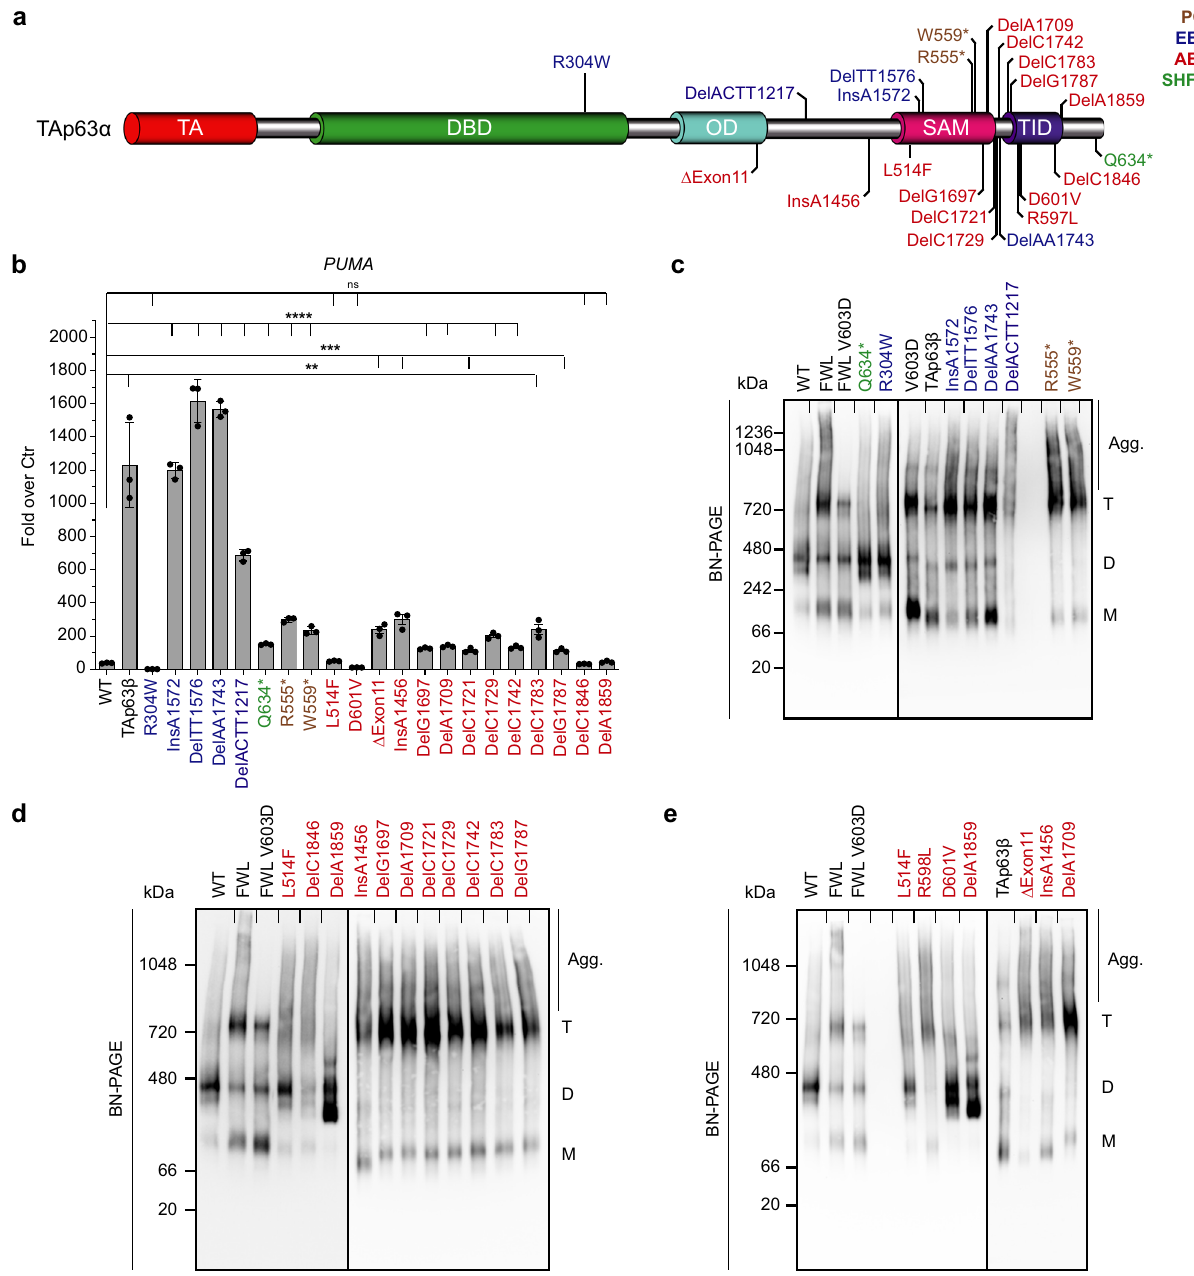
Fig. 5 Analysis of TAp63 α mutants ’ transactivation activity and oligomeric states. a Overview of different syndromic mutations on TAp63 α . ELA mutations are represented in blue, AEC/RHS in red, SHFM in green and POI mutations in brown. b The relative luciferase activity expressed as fold over control (Ctr) shows the ability of wild-type or mutant p63 variants to transactivate the PUMA promoters. n = 3 biologically independent experiments, luciferase assay was performed in triplicates on PUMA 4xBS2WT responsive elements (REs). Data are presented as mean ± SD, ** p -value < 0.01, *** p -value < 0.001, **** p -value < 0.0001, ns p -value > 0.05 by two-tailed unpaired Student ’ s t -test. Exact p -values are provided in Source Data fi le; c – e Oligomeric state analysis of mutant TAp63 α via blue native (BN)-PAGE. The oligomeric conformation is indicated by T (tetramer), D (dimer), M (monomer) and, additionally, Agg. for aggregation. Source data are provided as a Source Data fi